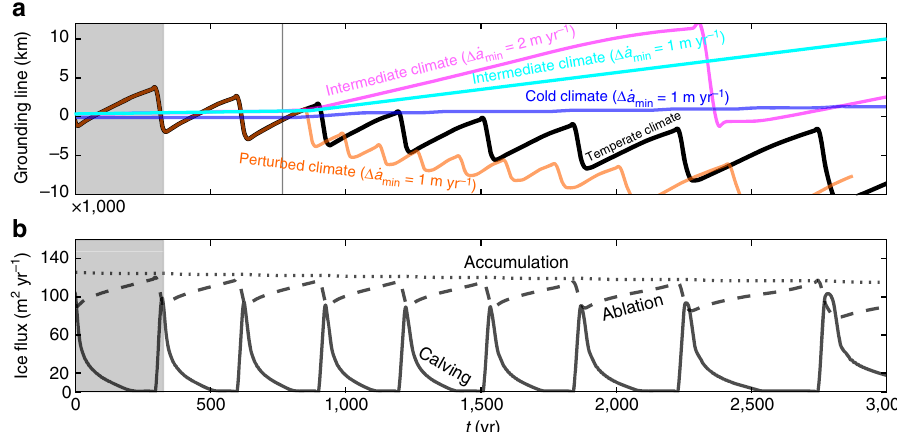
Fig. 4 Grounding line positions and ice fl ux under different climate scenarios. a Position of the grounding line for the fi rst 3 kyr of a 10 kyr simulation of the TGC. The black line shows the unperturbed temperate climate experiment. The orange line that partially overlaps, it shows the simulation in which the melt rate is increased by 1 m year − 1 beginning at the time indicated by the vertical line . The dark blue line shows this perturbed experiment but for a polar climate. The magenta and cyan lines show the perturbed experiment for an intermediate climate. Cycles continue past time frame shown. The decreasing trend in grounding line position, and the change in cycle length, is due to bedrock erosion and a change in bed shape. b Width-normalized fl uxes due to net surface accumulation, net ablation, and calving for the temperate